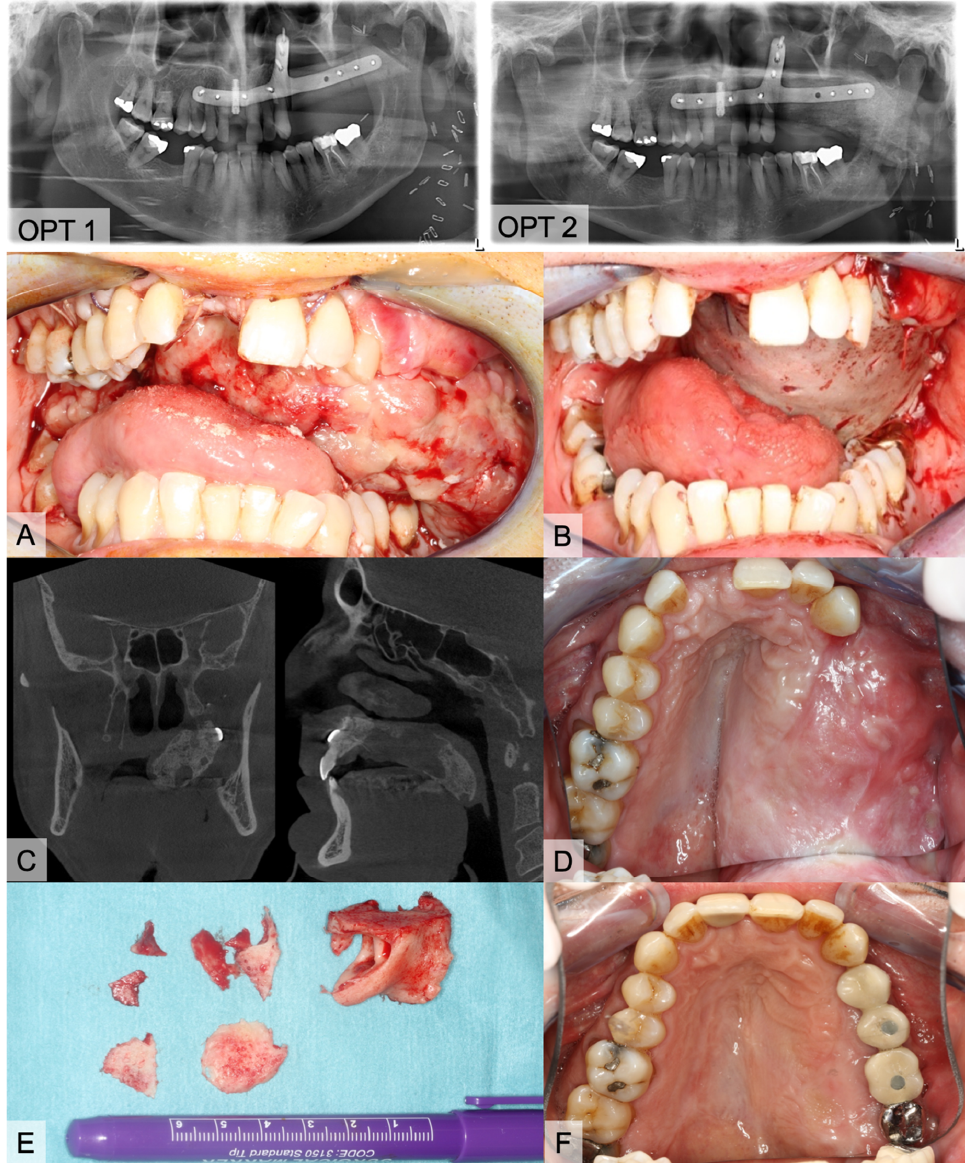
Figure 7. Images of an 54-year-old, healthy male who underwent subtotal hemi-maxillectomy due to a second recurrence of an odontogenic kerato-cyst (OKC). After more than one year later, we performed a virtually planned mono-segmental FFF transfer without a skin paddle for maxillary reconstruction (OPT 1). Three days after discharge, he consulted the emergency unit with progressive dyspnea and fear of asphyxiation in dorsal position. Clinical inspection showed large masses of soft and vulnerable granulation tissue ( A ). After carefully removing the tissue, we covered the bone with a split skin graft from the thigh ( B ). Six months later, we planned implantological rehabilitation. OPT and CBCT were accomplished and presented large bone masses at the palate ( C , OPT 2). Clinical impression is shown on image ( D ). Prior to the insertion of four dental implants, we molded the FFF and removed bone masses ( E ). Implants were exposed four months later. Figure ( F ) shows the final prosthetic rehabilitation.